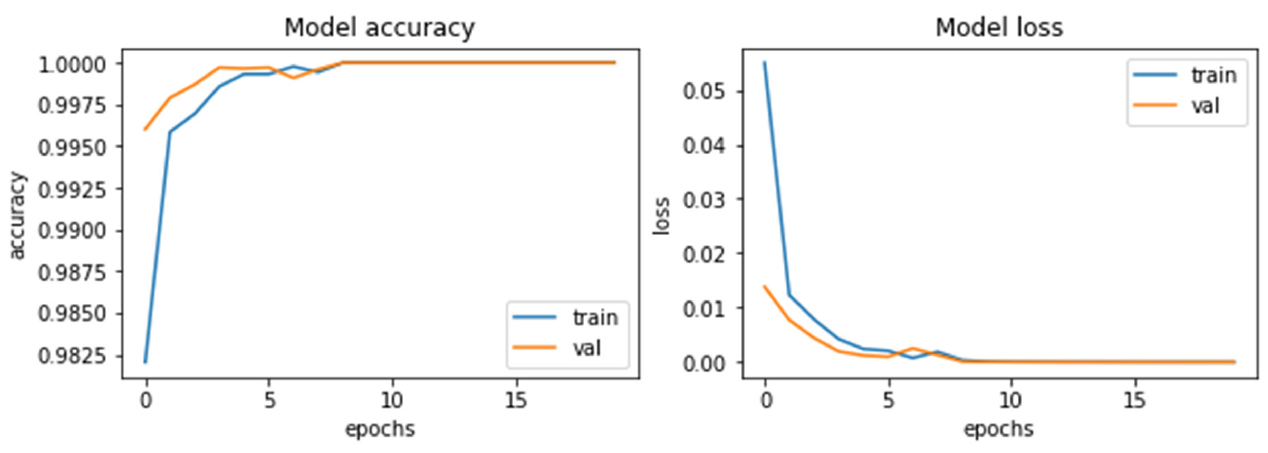
Figure 18. Accuracy and loss curves of MobileNet architecture.